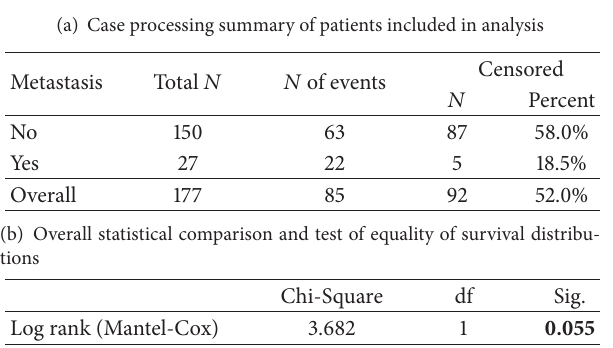
Table 2: Survival distribution stratified by presence of metastatic disease.